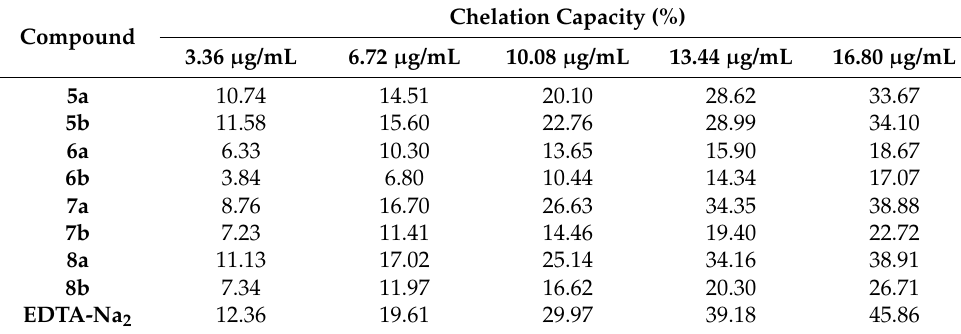
Table 6. Results of the cupric ions chelation capacity evaluation.